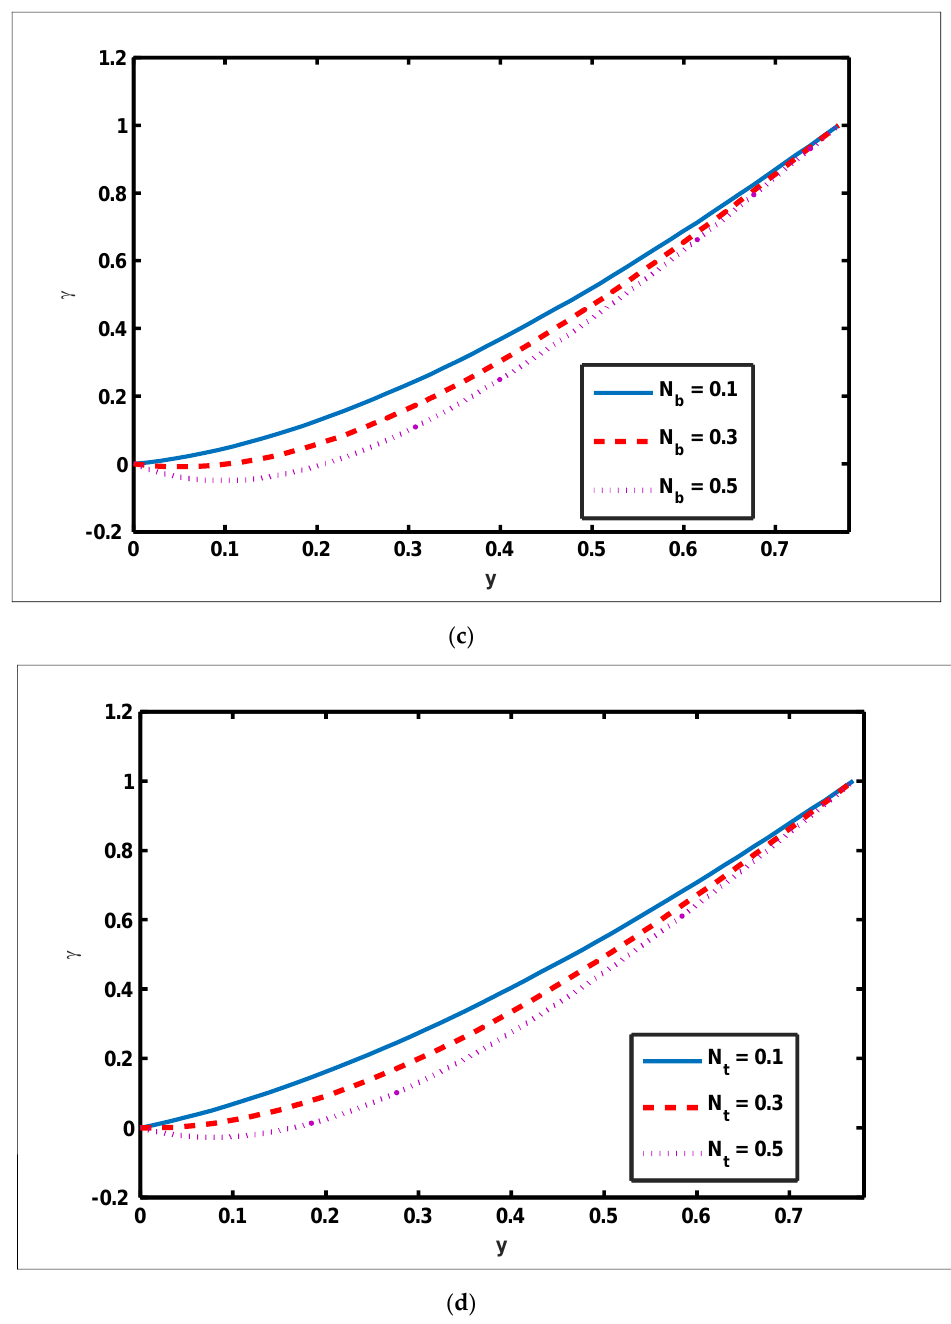
Figure 2. Concentration profile for Soret, Dufour, Brownian motion, and thermophoresis parameters. Values of other physical parameters are ( a ) 𝑁 𝑡 = 0.3,𝑁 𝑇𝐶 = 1.2,𝑁 𝑏 = 0.3,𝑏 = 0.7,𝑎 = 0.3,𝑥 = 0.6. ( b ) 𝑁 𝑏 = 0.2,𝑁 𝑡 = 0.3,𝑁 𝐶𝑇 = 0.9,𝑏 = 0.7,𝑎 = 0.3,𝑥 = 0.6. ( c ) 𝑁 𝑡 = 0.3,𝑁 𝑇𝐶 = 1.2,𝑁 𝐶𝑇 = 0.9,𝑏 = 0.7,𝑎 = 0.3,𝑥 = 0.6. ( d ) 𝑁 𝑏 = 0.2,𝑁 𝑇𝐶 = 1.2,𝑁 𝐶𝑇 = 0.9,𝑏 = 0.7,𝑎 = 0.3,𝑥 = 0.6.